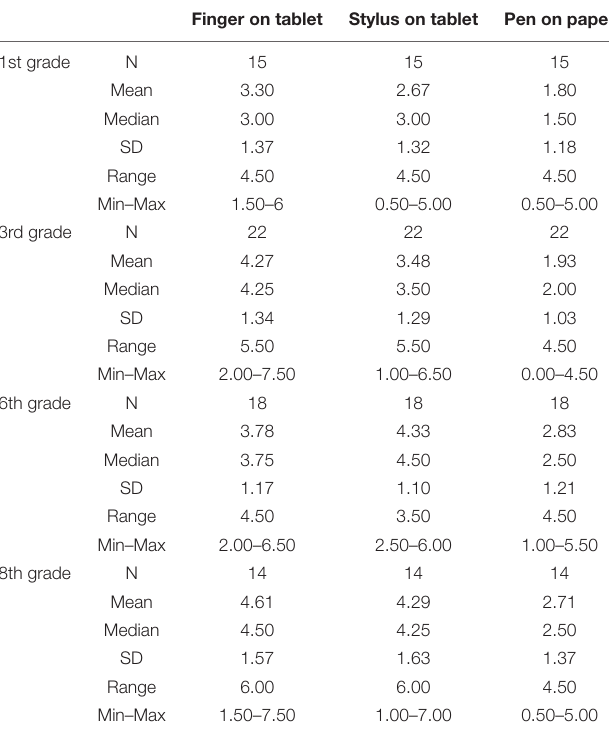
TABLE 3 | Descriptive analysis of originality scores according to the grade and tool